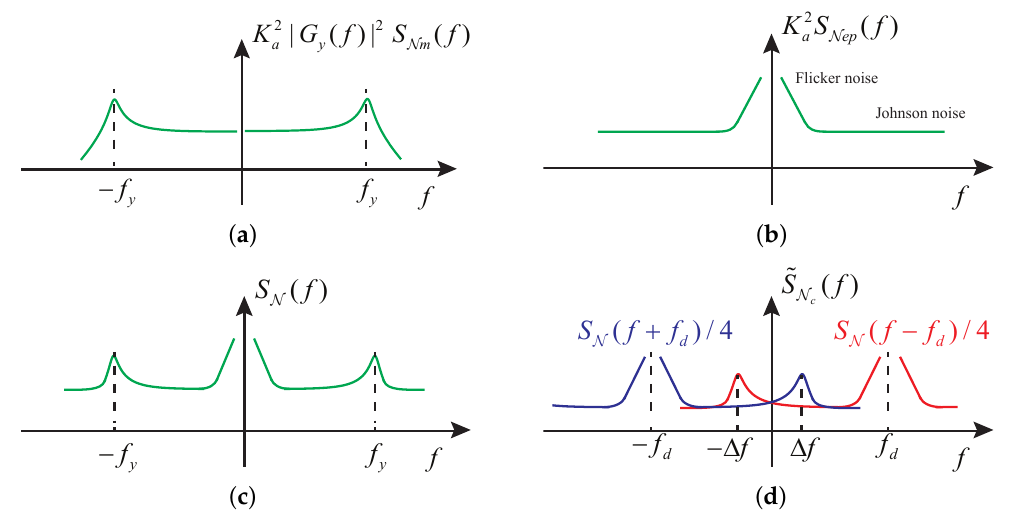
Figure 5. Noise propagation in the open-loop sense channel. ( a ) Noise power spectral density (PSD) in N ( t ) attributable to the mechanical noise; ( b ) Noise PSD in N ( t ) attributable to the electrical noise; ( c ) Noise synthesis of N ( t ) ; ( d ) Noise PSD after the modulation. ∆ f = ∆ ω /2 π